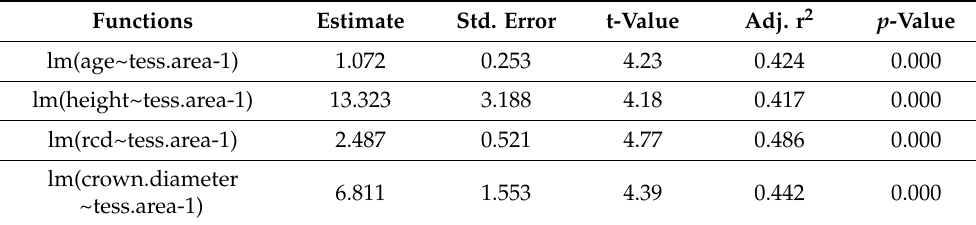
Table 6. Growth space of individual seedlings calculated by tessellation in relation to seedling growth parameters; all study sites included.